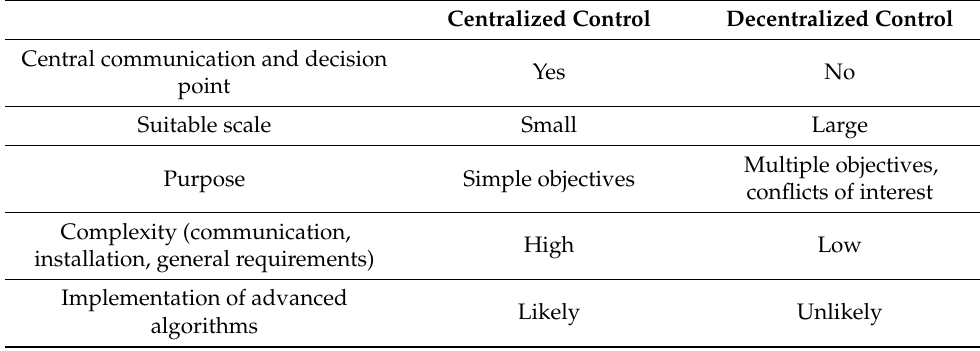
Table 4. Comparison between centralized and decentralized control (Data from